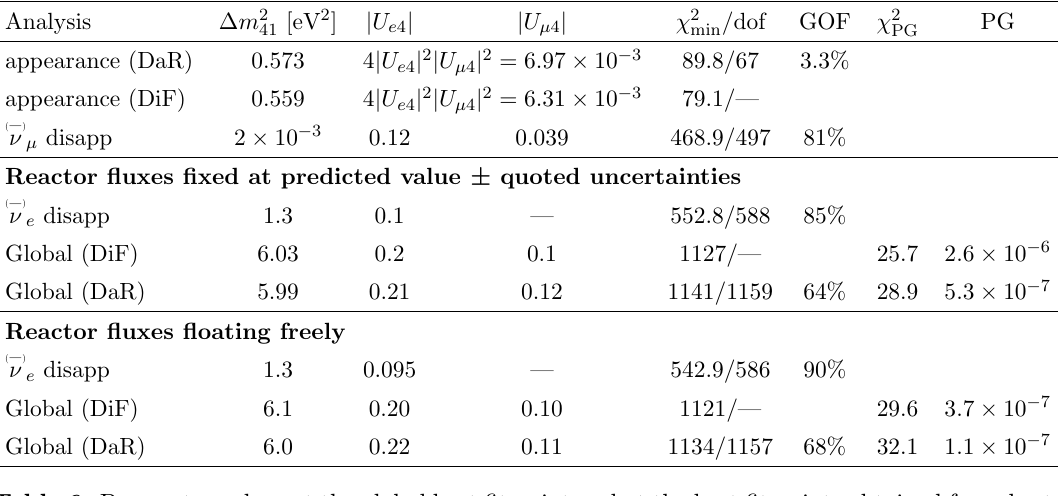
Table 6 . Parameter values at the global best (cid:12)t point and at the best (cid:12)t points obtained for subsets of the data. We also indicate the (cid:31) 2 per degree of freedom at the best (cid:12)t points, as well as the corresponding goodness-of-(cid:12)t values. The numbers of data points, and the parameters relevant to the counting of degrees of freedom are summarized in table 5. For the global (cid:12)t, we also indicate the results of the parameter goodness-of-(cid:12)t test [92] comparing appearance to disappearance data. The labels \DaR" and \DiF" refer to the LSND analysis employed, where \DiF" implies the joint use of DaR+DiF data, see section 4. Note that, as the number of degrees of freedom for the LSND DiF data is not available, we do not list the corresponding goodness of (cid:12)t